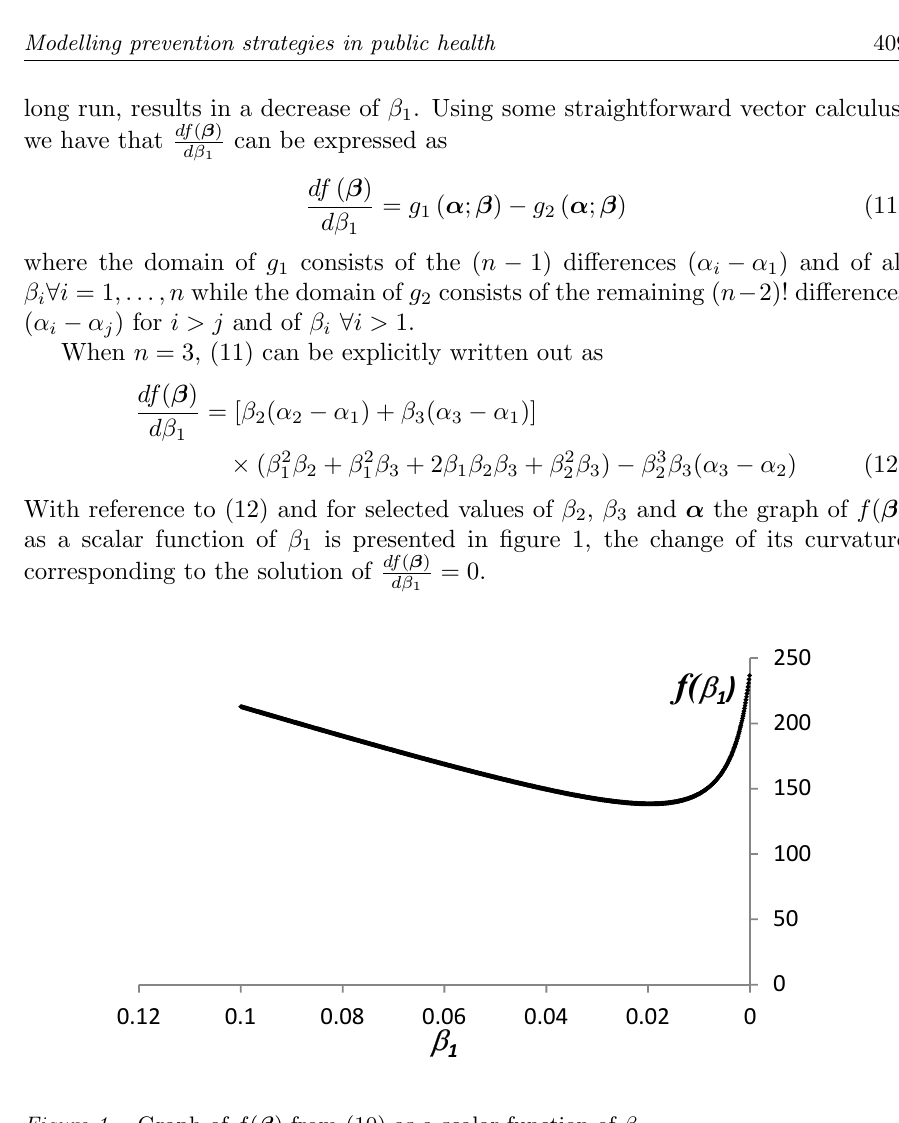
Figure 1 { Graph of f ( (cid:12) ) from (10) as a scalar function of (cid:12)